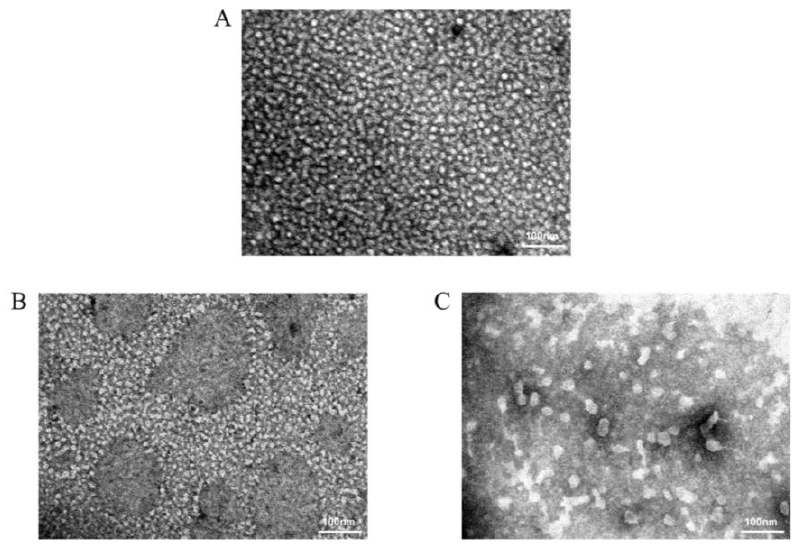
Figure 2. TEM images of target proteins: Px GST − EcR ( A ), Px GST − USP ( B ), and dimeric protein samples ( C ) after coincubation. Table 1. Zeta potentials of target proteins ( Px GST − EcR and Px GST − USP) and coincubated